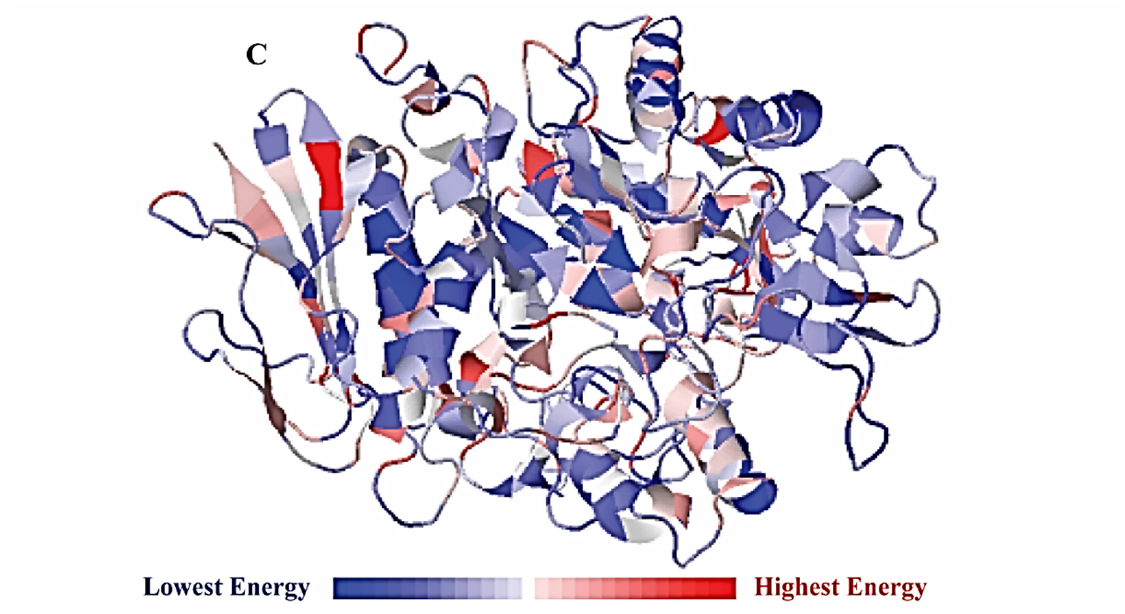
Figure 9. Overall quality of the α -glucosidase model from the ProSa-Web server. ( A ) Model residue; ( B ) NMR and X-ray structures comparison with the current model of the alpha-glucosidase; ( C ) high energy and lower energy regions.